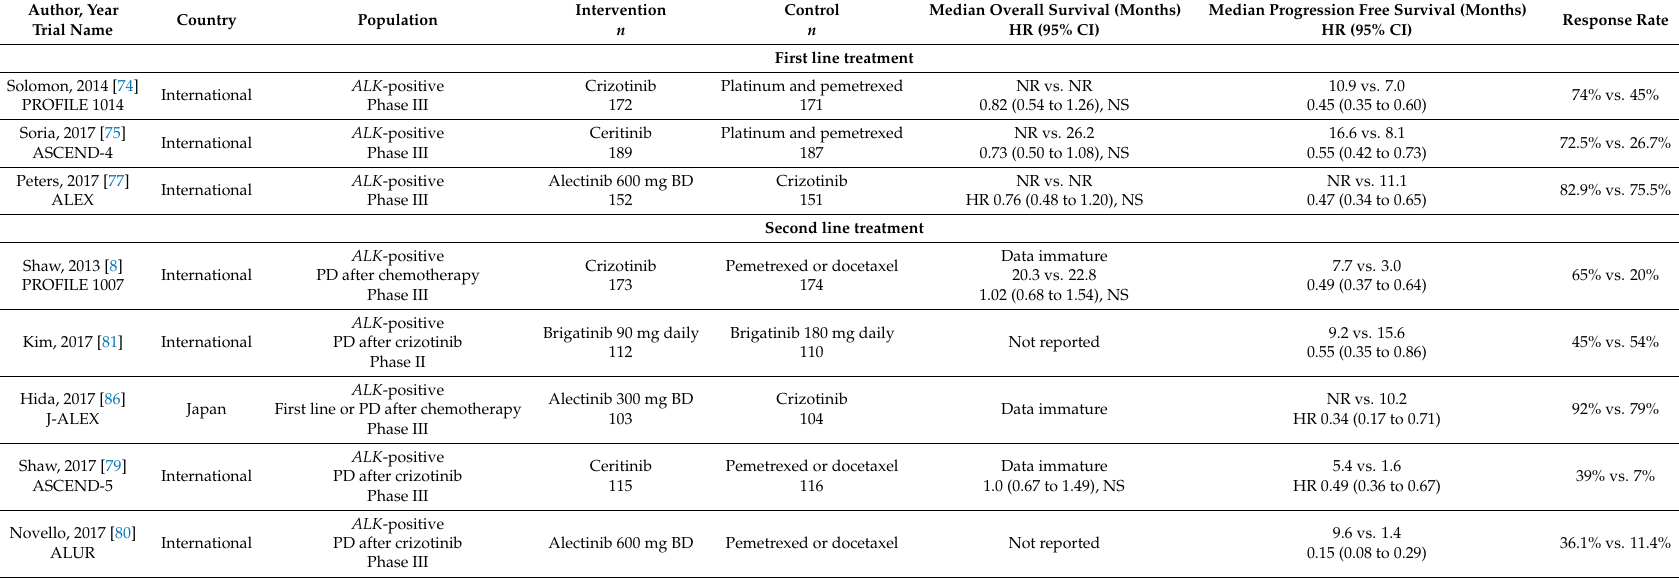
Table 3. Pivotal randomised controlled trials of Anaplastic Lymphoma Kinase (ALK) TKIs in patients with Stage IIIB/IV non-small cell lung